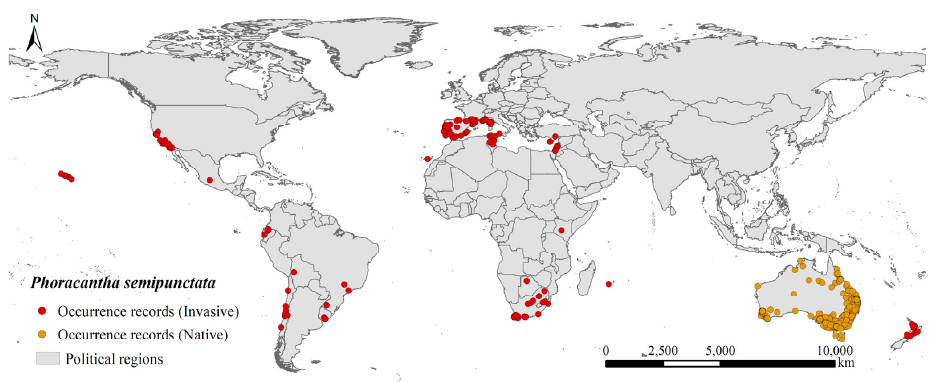
Figure 1. Invasive and native occurrence records of Phoracantha semipunctata worldwide.